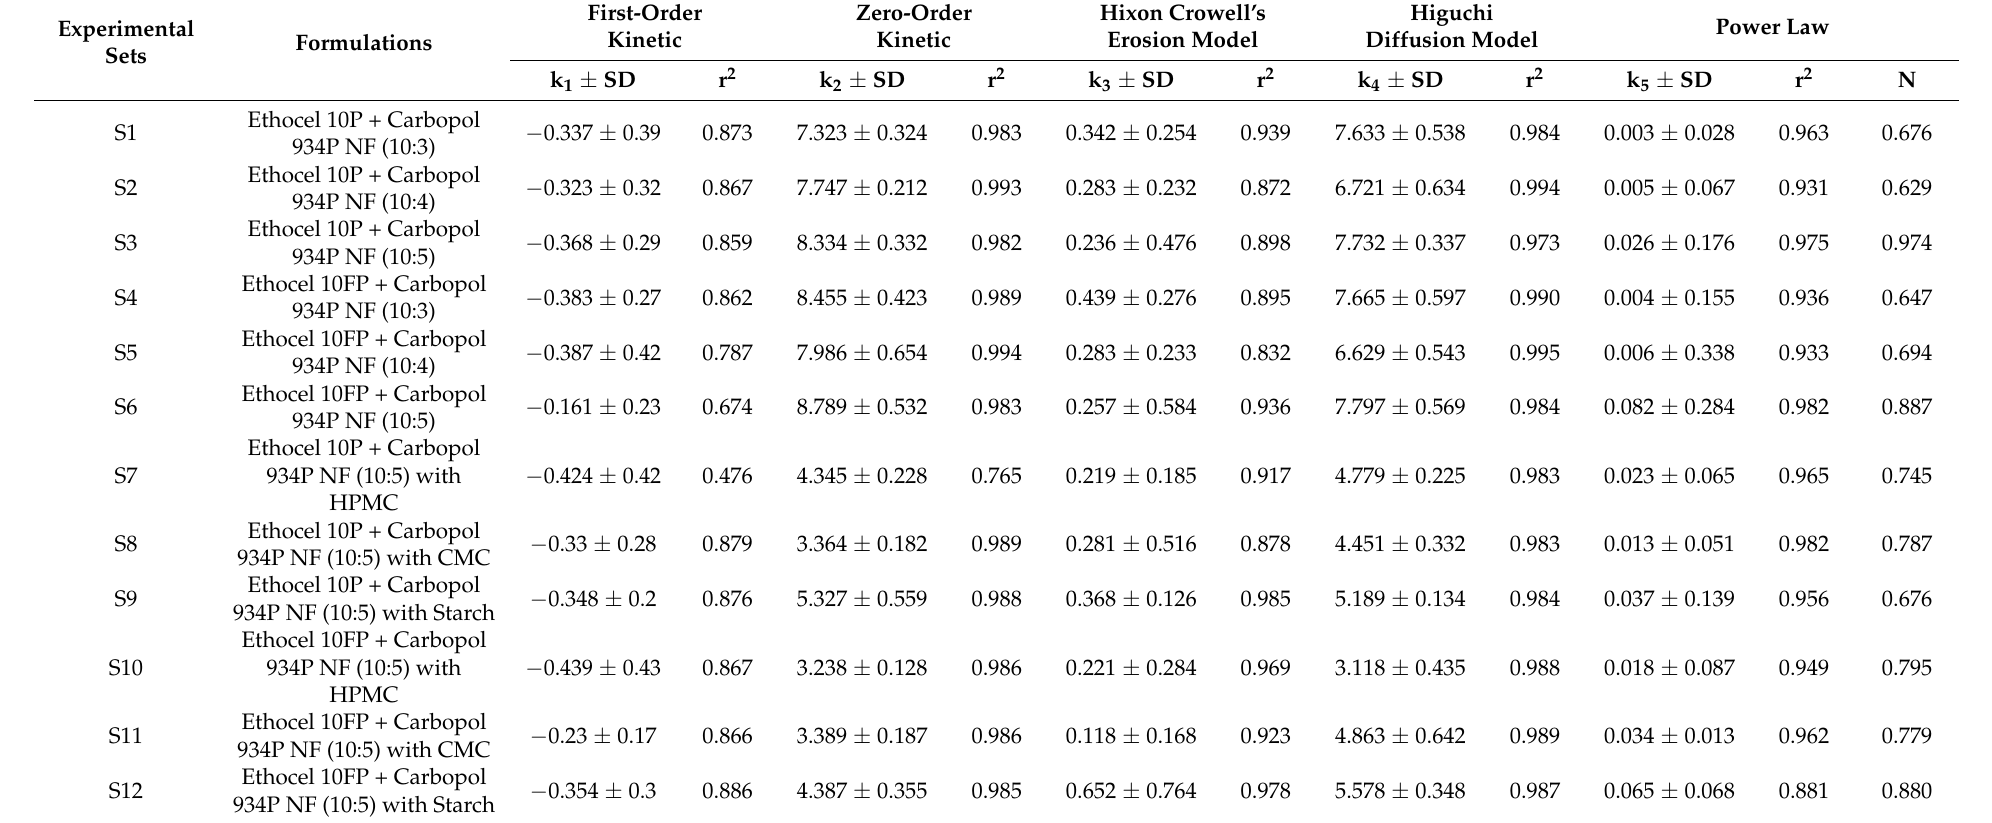
Table 5. Drug release kinetics parameters (n = 3, mean ±